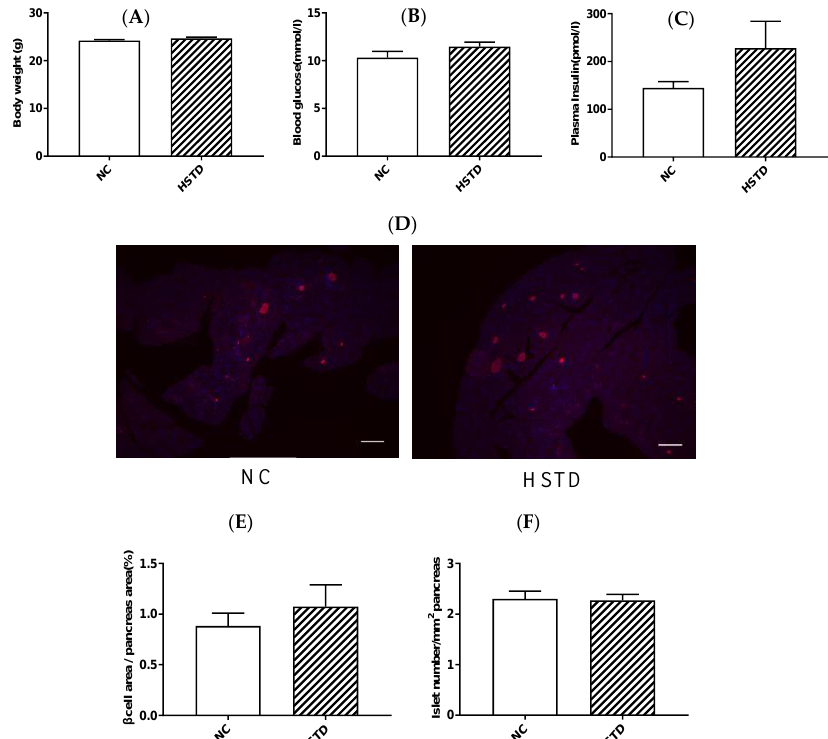
Figure 1. Body weight, metabolic parameters, β -cell mass (BCM), and islet number 3 weeks after intervention of diet in mice. ( A ) Body weight, ( B ) blood glucose and ( C ) plasma insulin levels under ad libitum fed condition. Normal chow (NC)-fed mice (white bar; n = 8); high starch, low-protein diet (HSTD)-fed mice (white hatched bar; n = 8) ( D ) The pancreatic section was stained with the antibody to insulin (red) and 40,6-diamidino-2-phenylindole (blue). Scale bars, 300 µ m. ( E ) β -Cell area relative to pancreas area. ( F ) Number of islets relative to pancreas area. Statistical comparisons were done by unpaired Student’s t test in ( A – C , E , F ). Data represent means ± SEM.